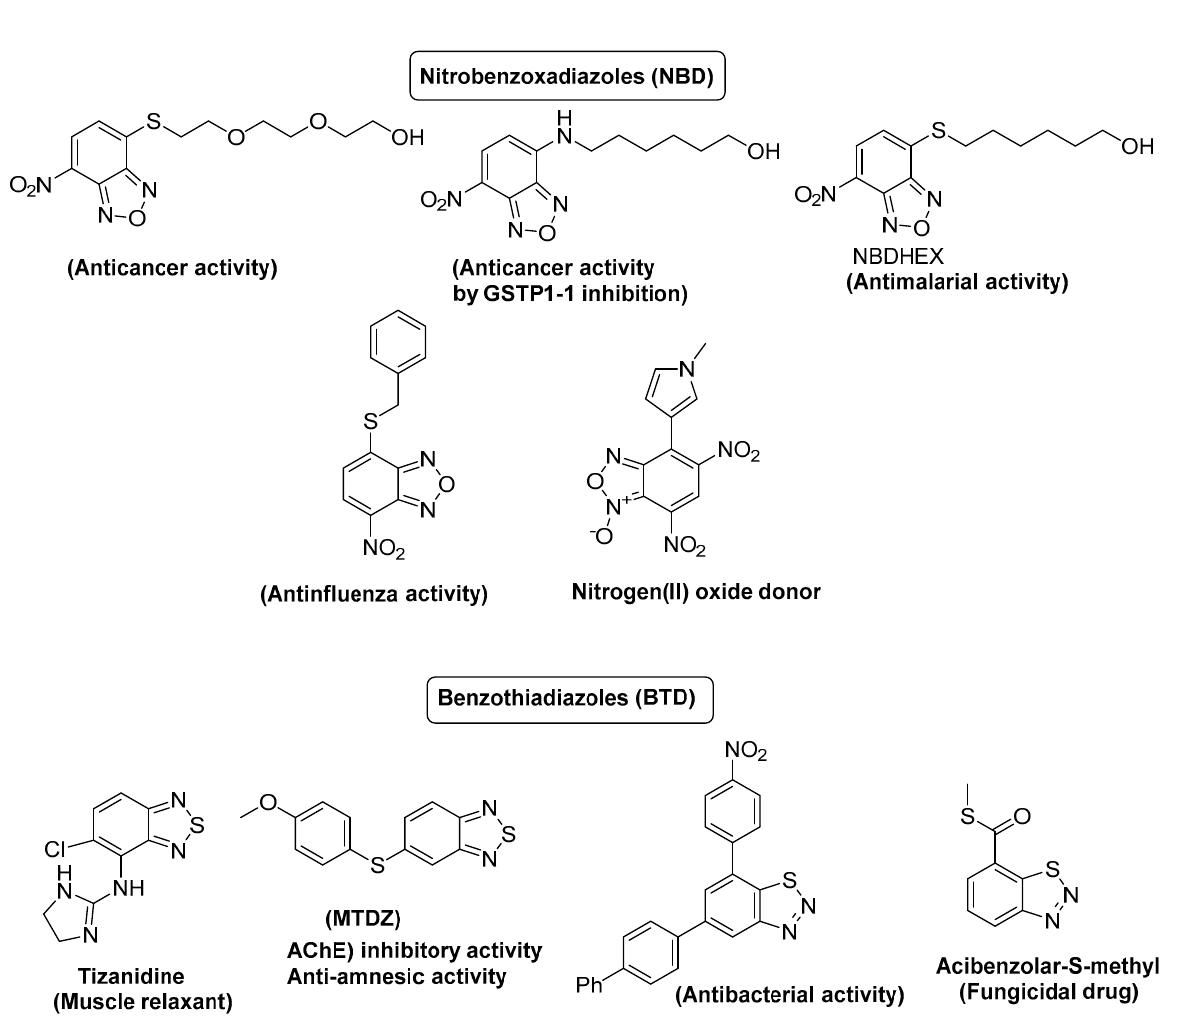
Figure 3. Structure of some nitrobenzoxadiazoles and benzothiadiazoles